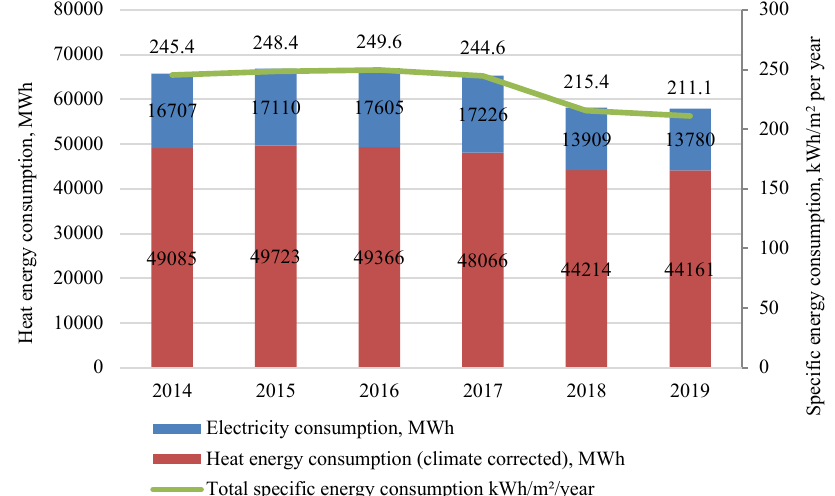
Fig. 9. Total energy consumption of 123 municipal buildings in Daugavpils (in 2014 and 2015 only partial historical data are available and energy consumption was